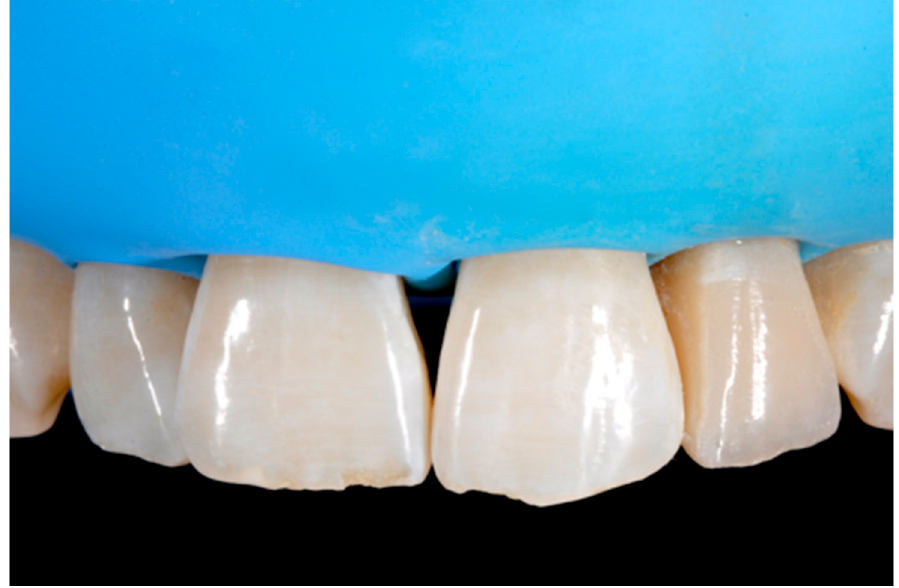
Figure 27. Clinical situation after polishing procedures. Reprinted from Restauri diretti nei settori anteriori, G. Paolone, S. Scolavino, © 2021, with permission from Quintessence Publishing Italy.